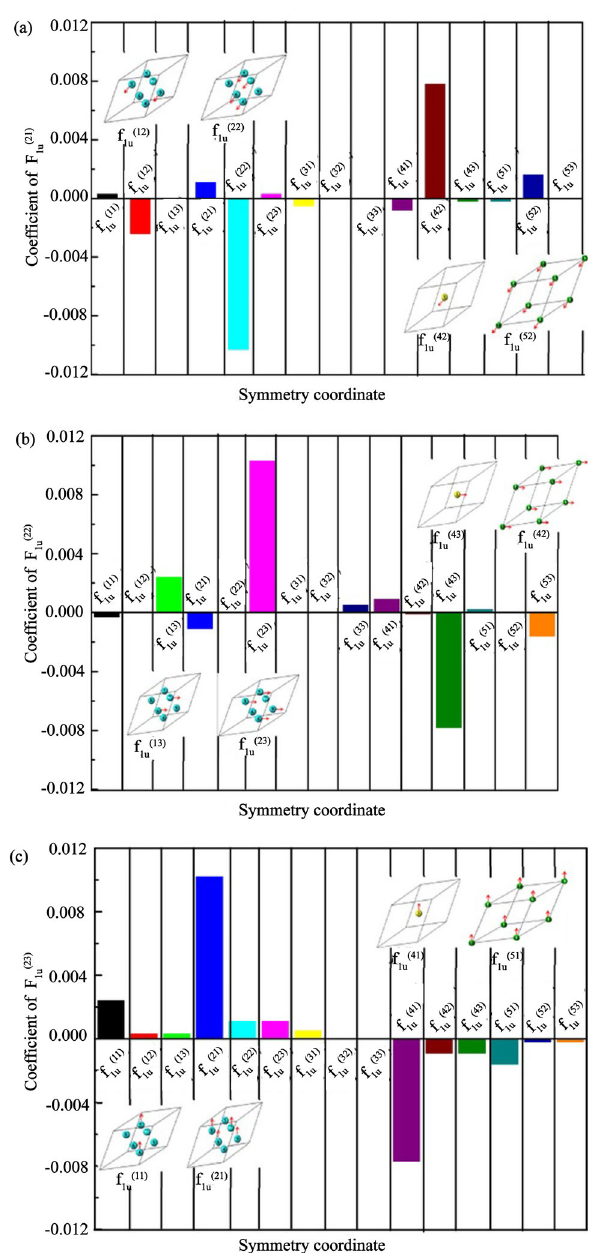
Fig. 21 Combinations of the symmetry coordinates (normalized) for IR-active F 1u (2) modes. Reproduced with permission from Ref. [476], © The American Ceramic Society